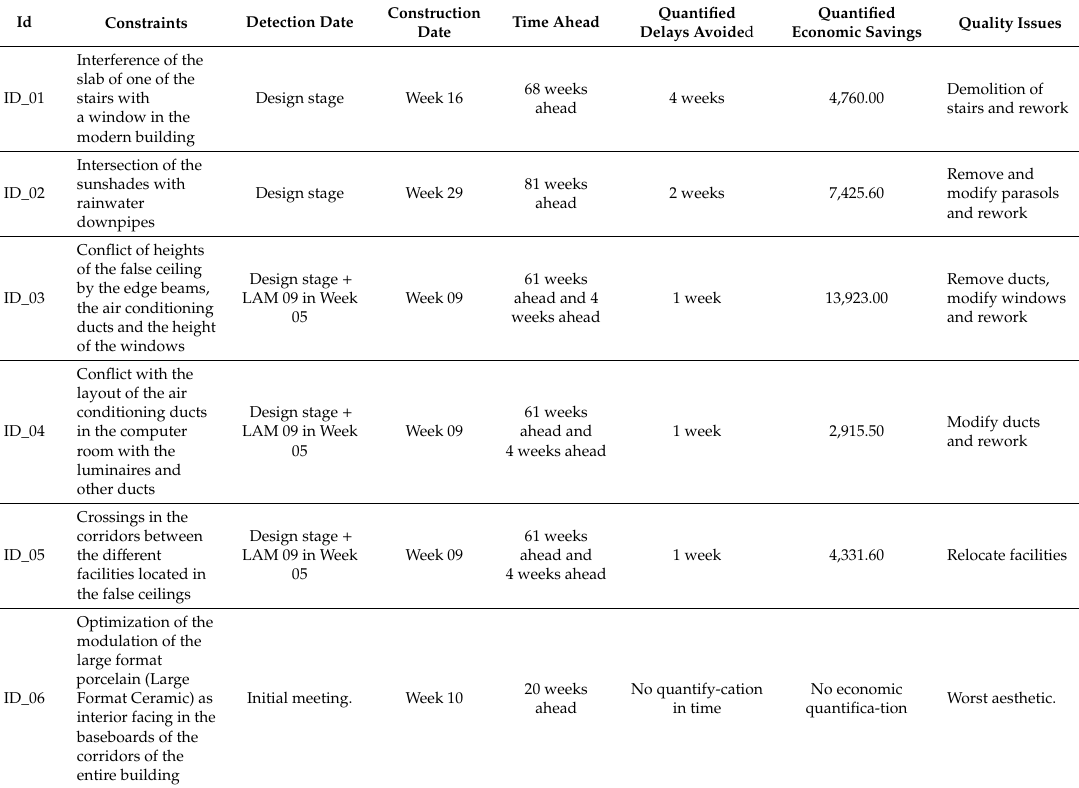
Table 1. Summary of incidents and deficiencies identified throughout the case